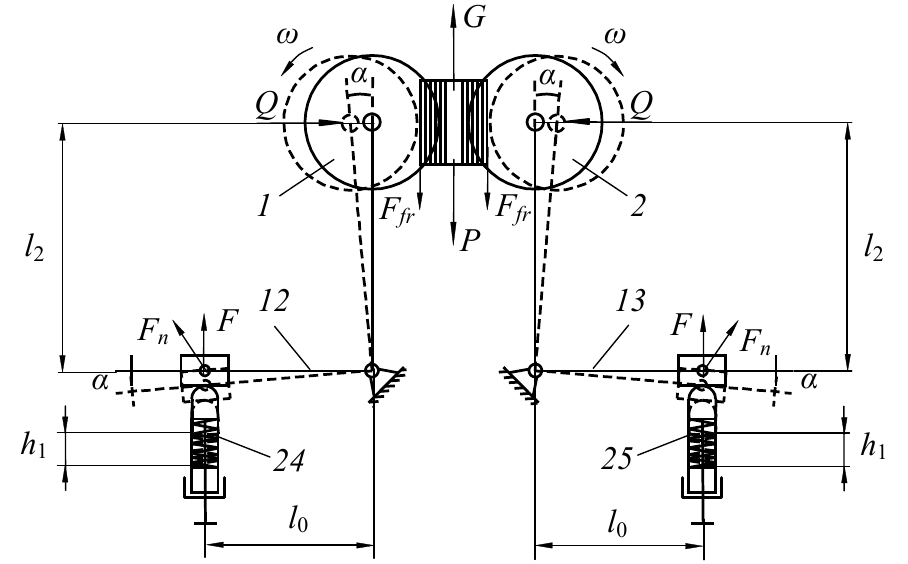
Figure 5. Scheme for calculating the parameters of the pressure mechanism of the roller machine.